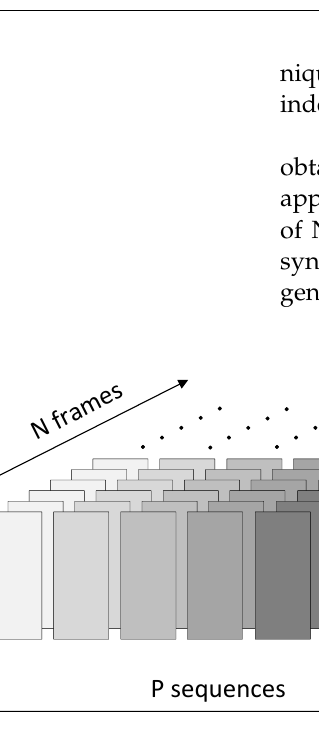
Figure 2. Dimension reduction scheme applied with the proposed colorization